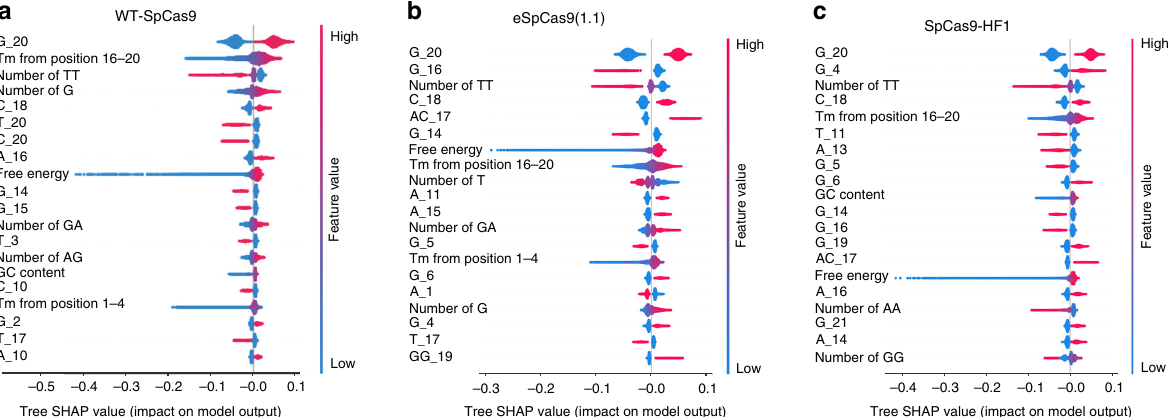
Fig. 3 Analysis of feature importance associated with gRNA activity by Tree SHAP. a – c Top 20% important features identi fi ed by Tree SHAP for WT- SpCas9, eSpCas9(1.1), and SpCas9-HF1, respectively. The nucleotides, as well as their position, were shown on the left. GG_19 means GG dimer start at position 19. T m means melting